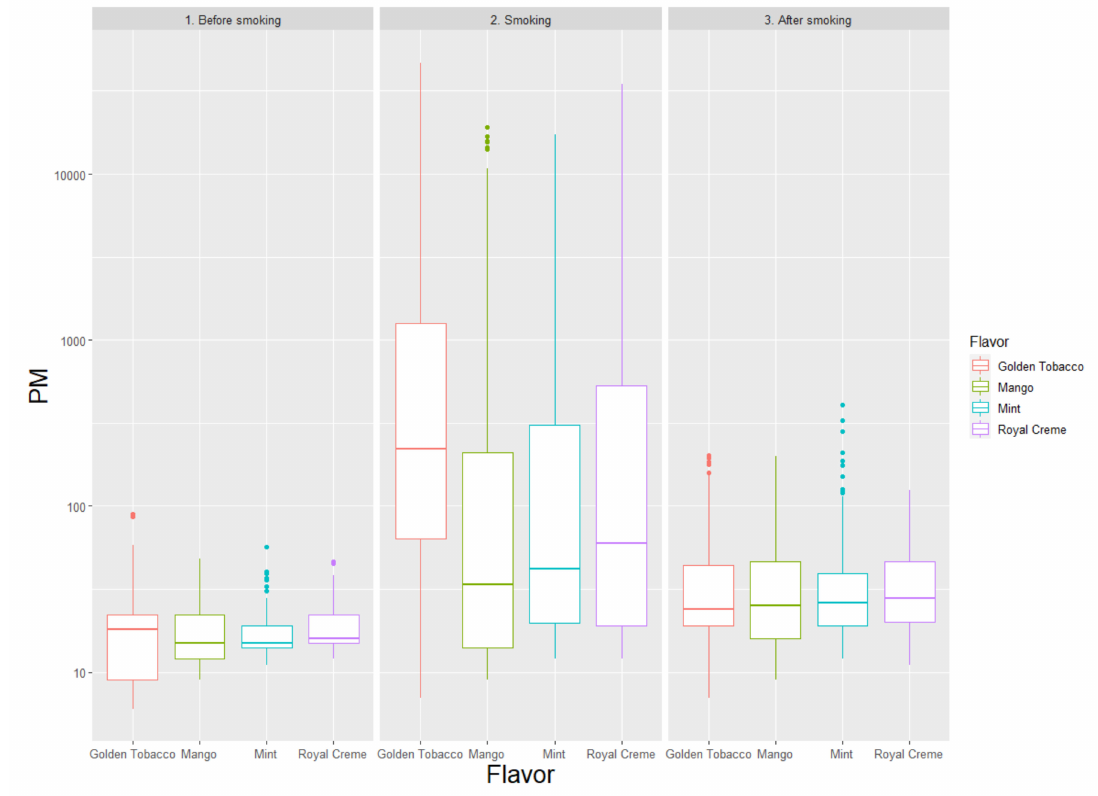
Figure 4. Levels of total particulate matter (PM), expressed as µ g / m 3 , comparing di ff erent flavors of Juul, distinguishing the following phases: before smoking (1), smoking (2), and after smoking